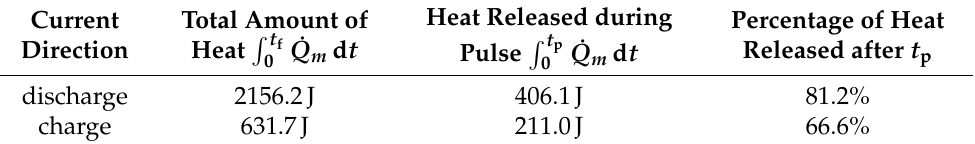
Figure 4. Measured heat flow over time for a 69A (3C) current pulse with a duration of 2min, which corresponds to a 10% change in the SoC. In this particular measurement the SoC has changed from 60% to 70%. The 2min current pulse duration is marked with the black dashed line. Table 2. Total amount of heat generated during a 3C charge/discharge pulse, compared to the amount of heat released during the first 2min. Thereby, t f = 60min is the total time of the experiment, while t p = 2min is the current pulse